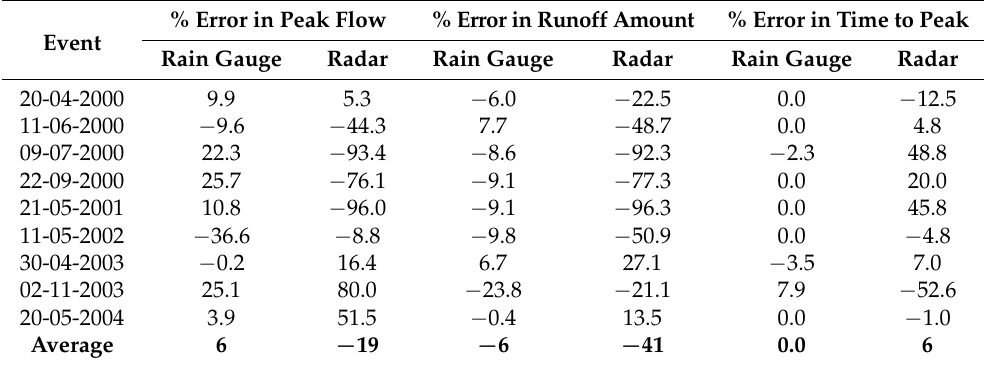
Table 5. Statistical comparison between observed and simulated peak flow rate, runoff amount, and time to peak using calibrated SCS model